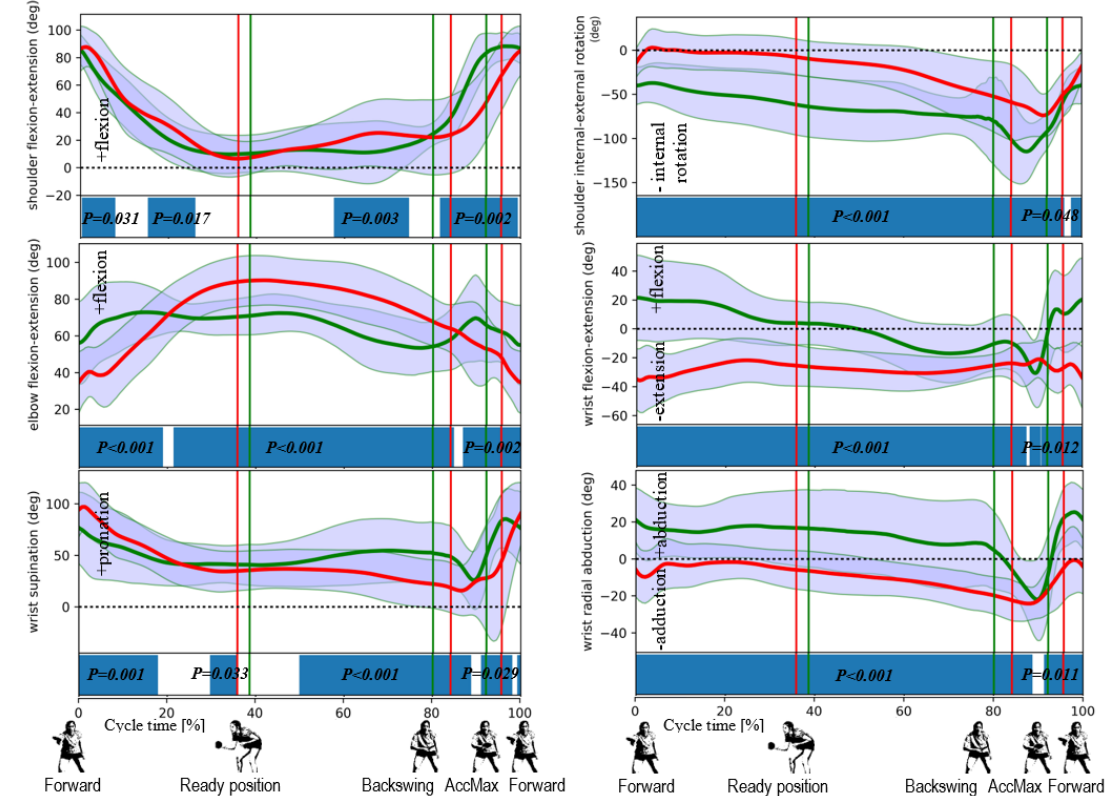
Figure 6. Differences in upper body angular kinematics between female (in red) and male (in green) players revealed by the SPM for the shoulder flexion-extension, shoulder abduction-adduction, shoulder internal-external rotation, elbow flexion-extension, wrist flexion-extension, wrist supination, and wrist radial abduction for the playing side. The statistically significant differences (for p < 0.05) are marked on the horizontal bar.